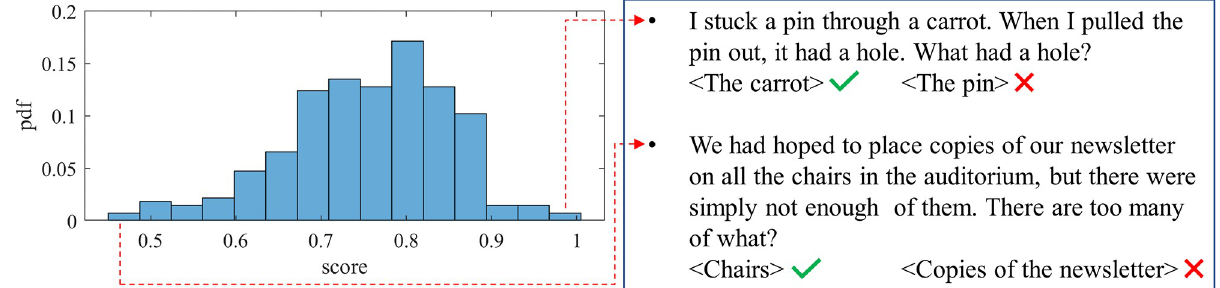
Fig 10. Winograd task: Distribution of the average score given different stimuli. Some examples with very high and very low scores are provided on the right.